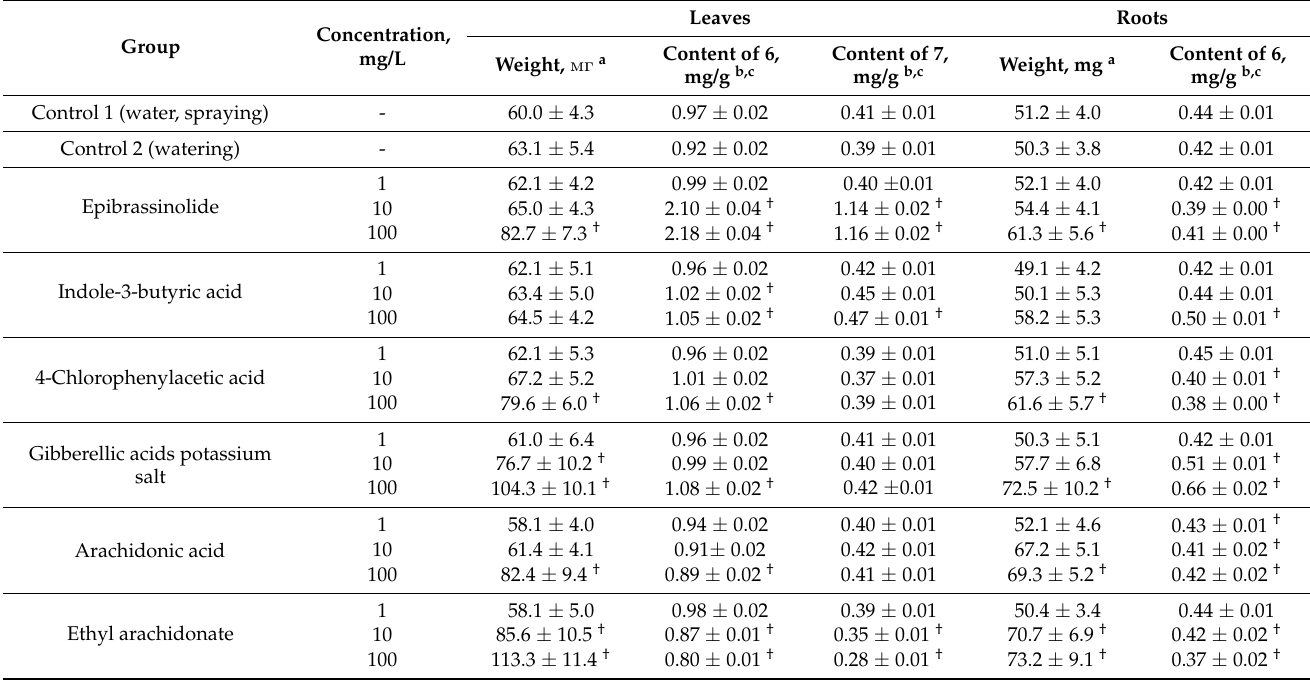
Table 1. Average weight of leaves and roots per plant and total content of 20-hydroxyecdysone ( 6 ) and polypodine B ( 7 ) in S. repens seedlings after 1 month of phytohormones and elicitors